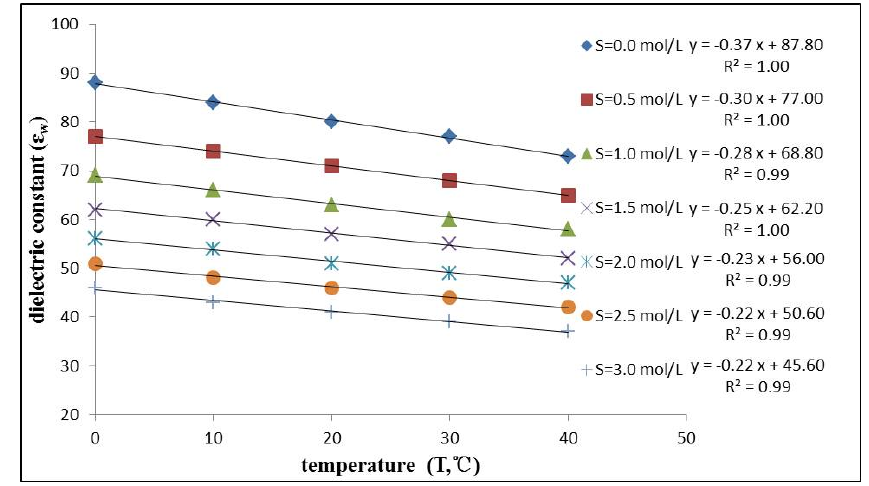
Figure 6. Dielectric constant variation with temperature under different concentrations of NaCl solutions (original data from Lane [20]).